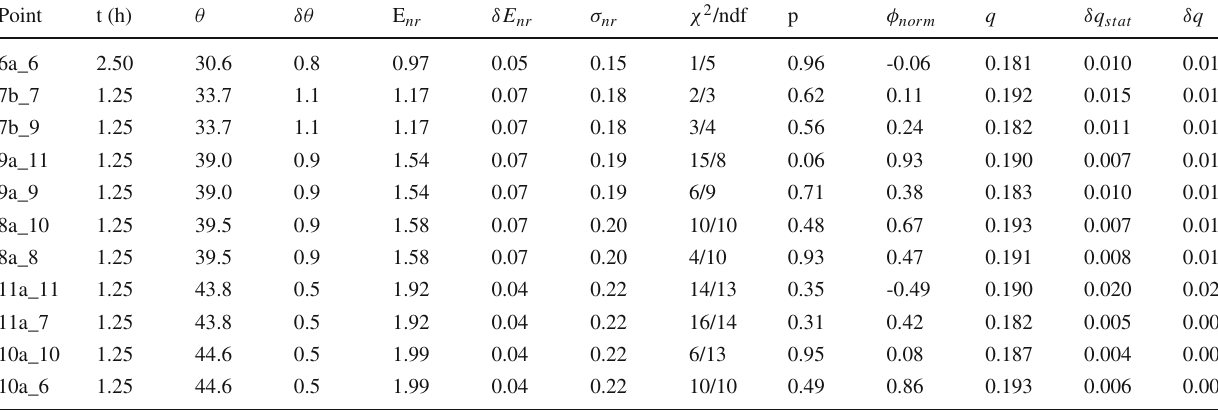
Analysis results for the coincidence distributions of runs 3 and 4 obtained with E n , 0 =